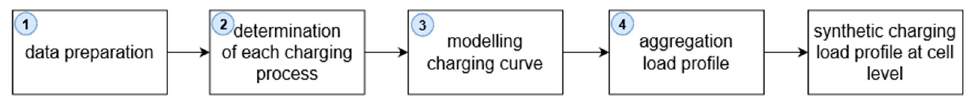
Figure 5. Overview: determination of synthetic charging load profiles of electric vehicles.